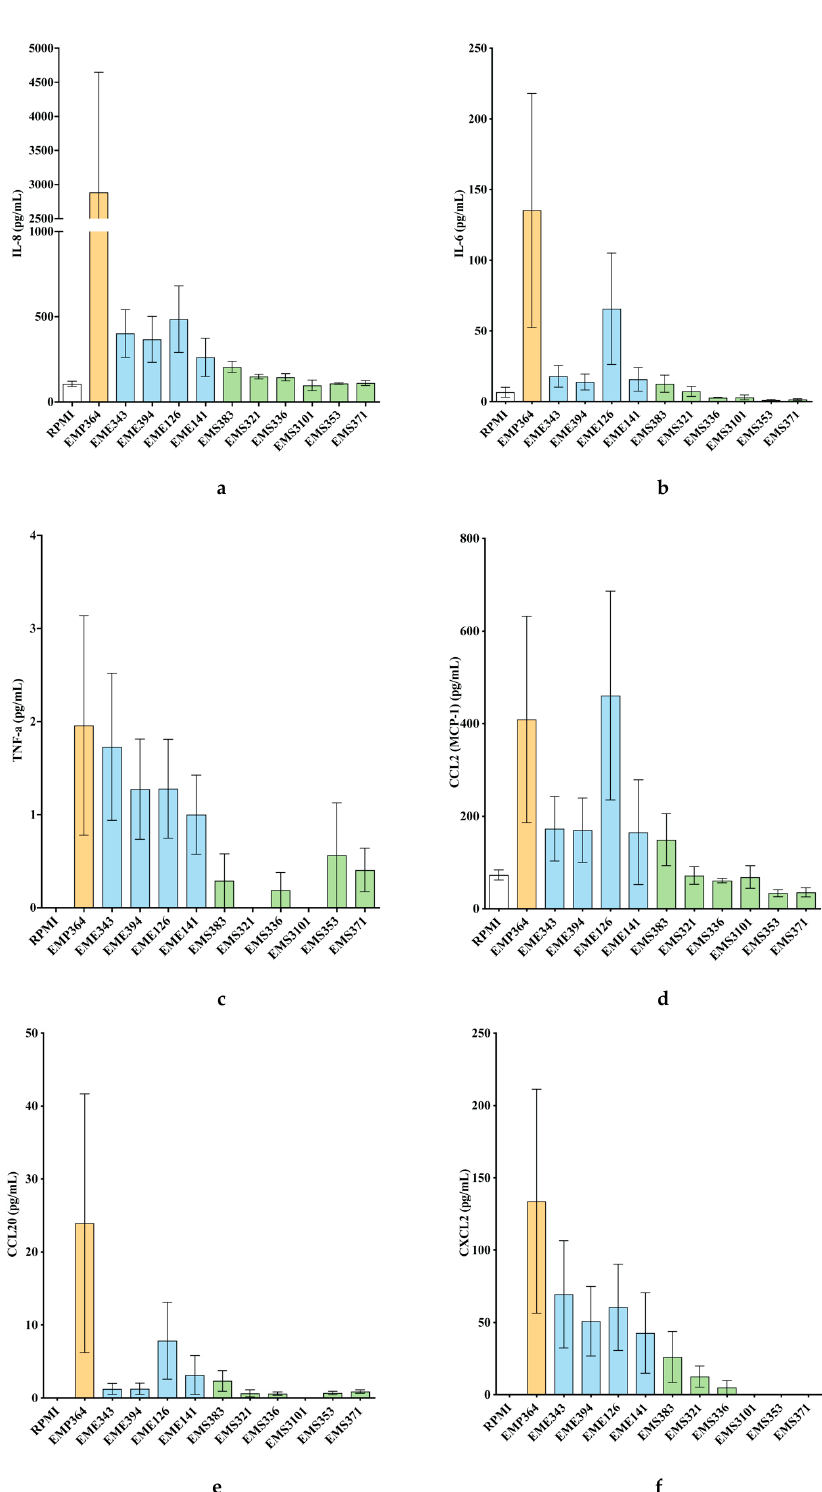
Figure 3. Cytokines and chemokines profiling of the BEAS-2B cells in response to bacterial stimulation: ( a ) IL-8, ( b ) IL-6, ( c ) TNF- α , ( d ) CCL2, ( e ) CCL20 and ( f ) CXCL2. Strains are identified as follows: EMS , Streptococcus strains; EME , Enterococcus strains; EMP , Pantoea . For the challenge assay, BEAS-2B cells were co-incubated with bacterial strains (MOI of 100:1) for 6 h, in 25 cm 2 tissue culture flasks. Cytokines and chemokines were quantified by using multiplex-magnetic-beads-based assay. Data are the mean of secreted proteins (pg / mL) ± SEM of four biological replicates (with two technical replicates each). p -values: *: p < 0.03, **: p < 0.002, ***: p < 0.0002 and ****: p <